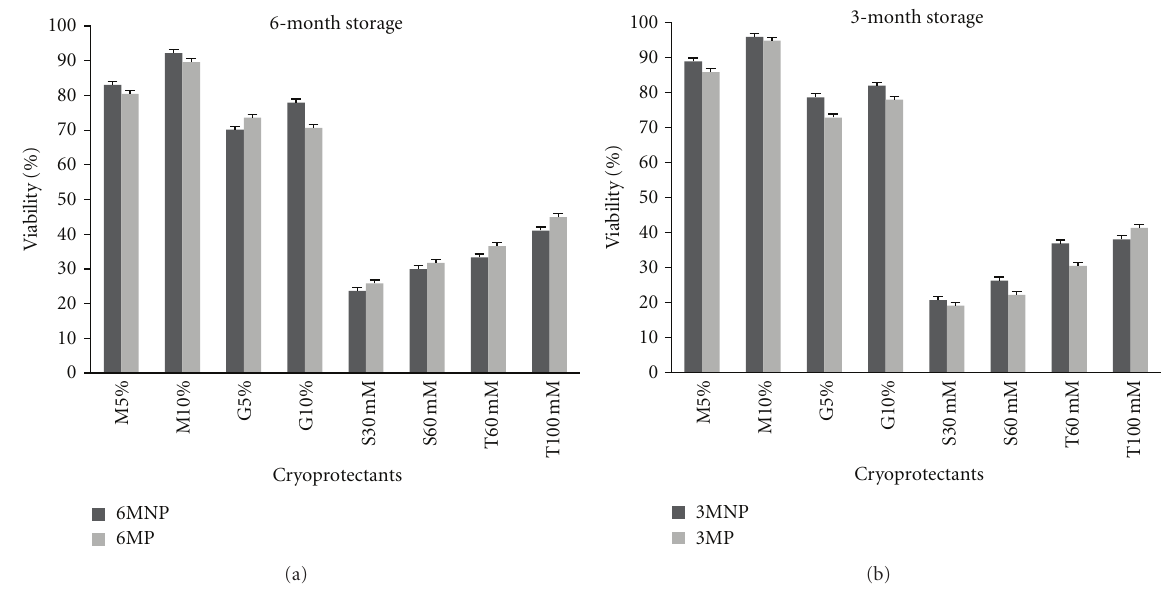
Figure 5: AFSCs viability comparing nonprogrammed and programmed freezing protocols. we did not have statistic di ff erences in AFSCs viability when we compared the two freezing methods tested. (a) AFSCs viability after 6 months in programmed and nonprogrammed freezing using di ff erent cryoprotectants. (b) AFSCs viability after 3 months in programmed and nonprogrammed freezing using di ff erent cryoprotectants. M-Me 2 SO, G-glycerol, S-sucroses and T-trehalose. Means were compared by one-way ANOVA Dunnett posttest ( ∗ P < 0 . 05).